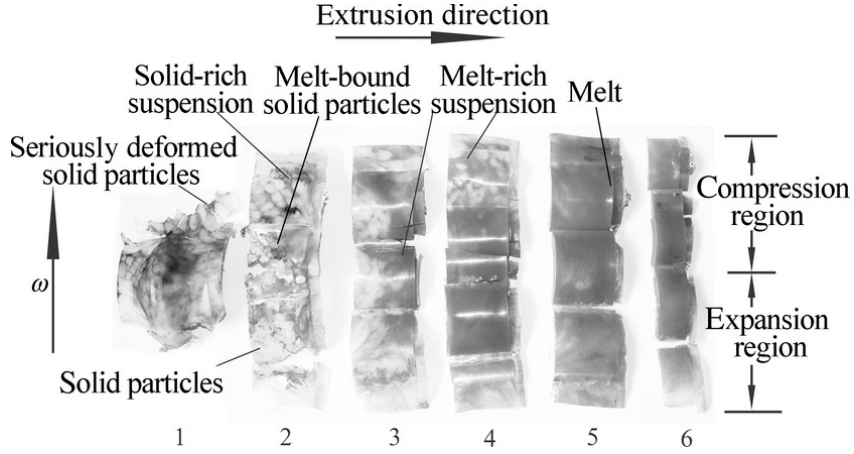
Figure 6. Photographs of high-density polyethylene (HDPE) removed from six VE units. Reproduced with permission for [32]. Copyright 2013, John Wiley and Sons.